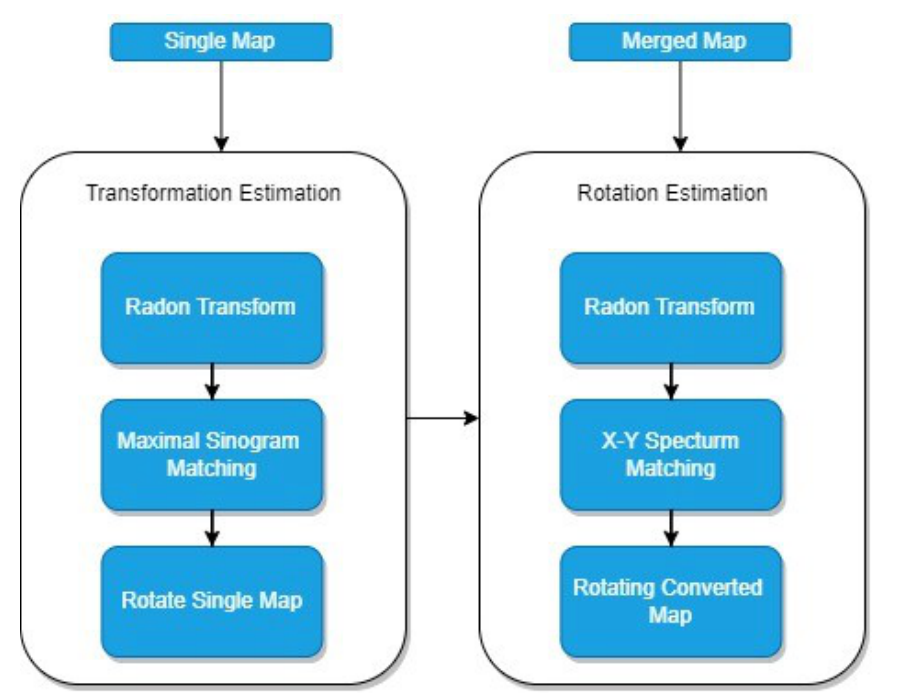
Figure 16. Structure of sinogram-based map